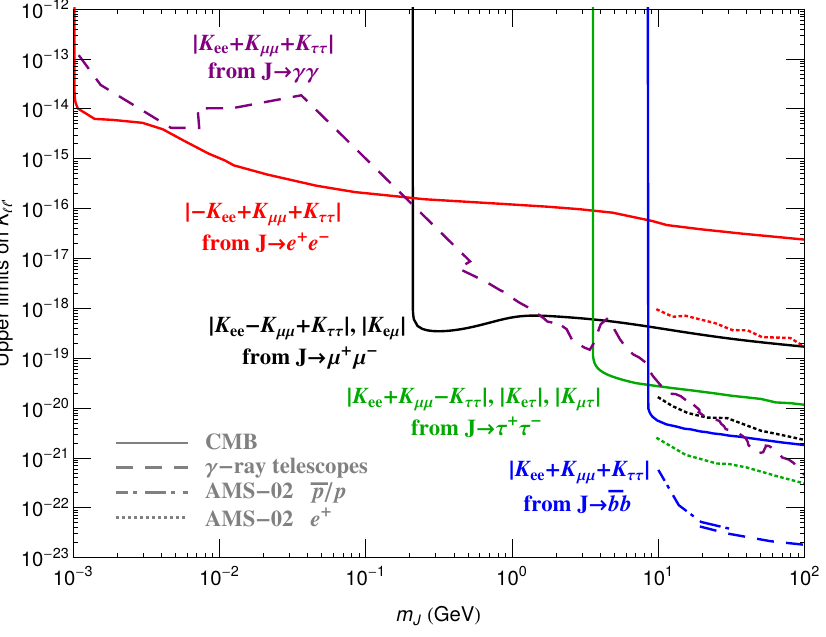
Figure 5 . Upper bounds on the matrix elements K ‘‘ 0 or combinations of them from CMB measurements [72] and indirect DM searches with AMS-02 [65, 73]; (cid:13) -ray telescope limits on J ! (cid:13)(cid:13) and J ! (cid:22) bb refer to INTEGRAL [74] for m J < 7 MeV, to COMPTEL/EGRET [75] for 7 MeV (cid:20) m J (cid:20) 400 MeV, and to Fermi-LAT [76, 77] for m J > 400 MeV. For indirect DM searches, we only show the most constraining limits in a given channel. We remind the reader that K is expected to have an order of magnitude of 10 (cid:0) 13 (cid:21) , where (cid:21) is the Yukawa in eq.